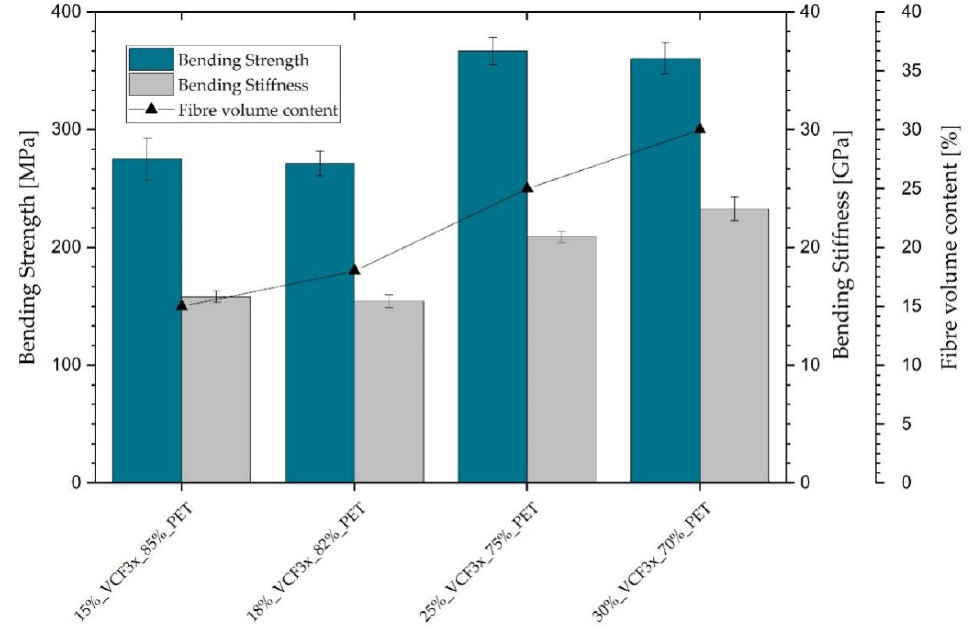
Figure 5. The bending strength and bending stiffness of four PET nonwovens with 15%, 18%, 25%, and 30% fiber volume contents. Table 7. The 0° and 90° properties of nonwovens by using different carbon fiber volume contents.